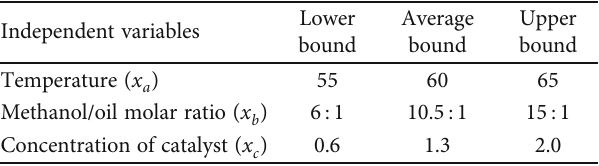
Table 1: For biodiesel production range and level coding of design